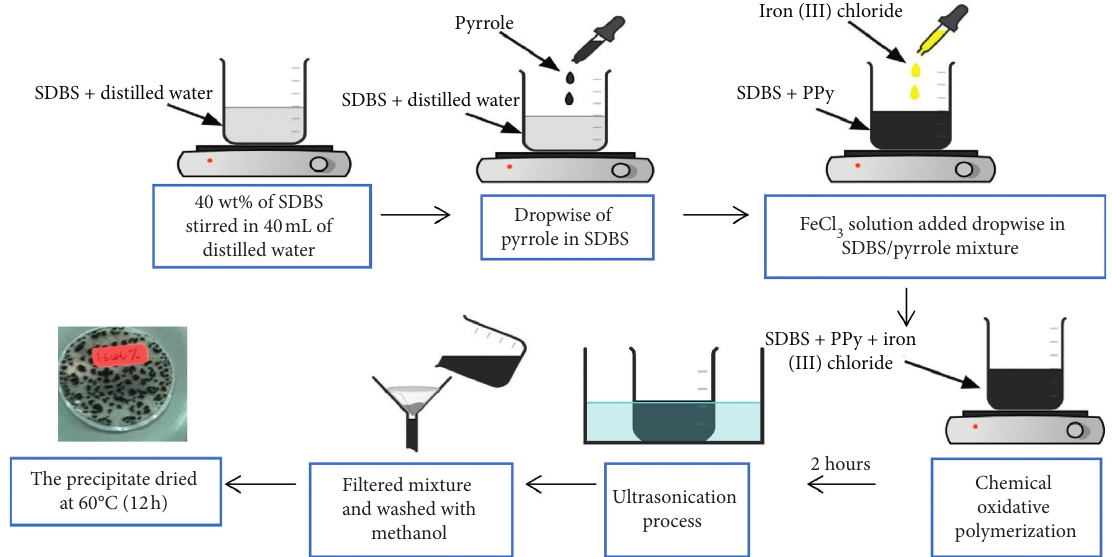
Figure 1: Schematic diagram for the PPy NPs polymerisation